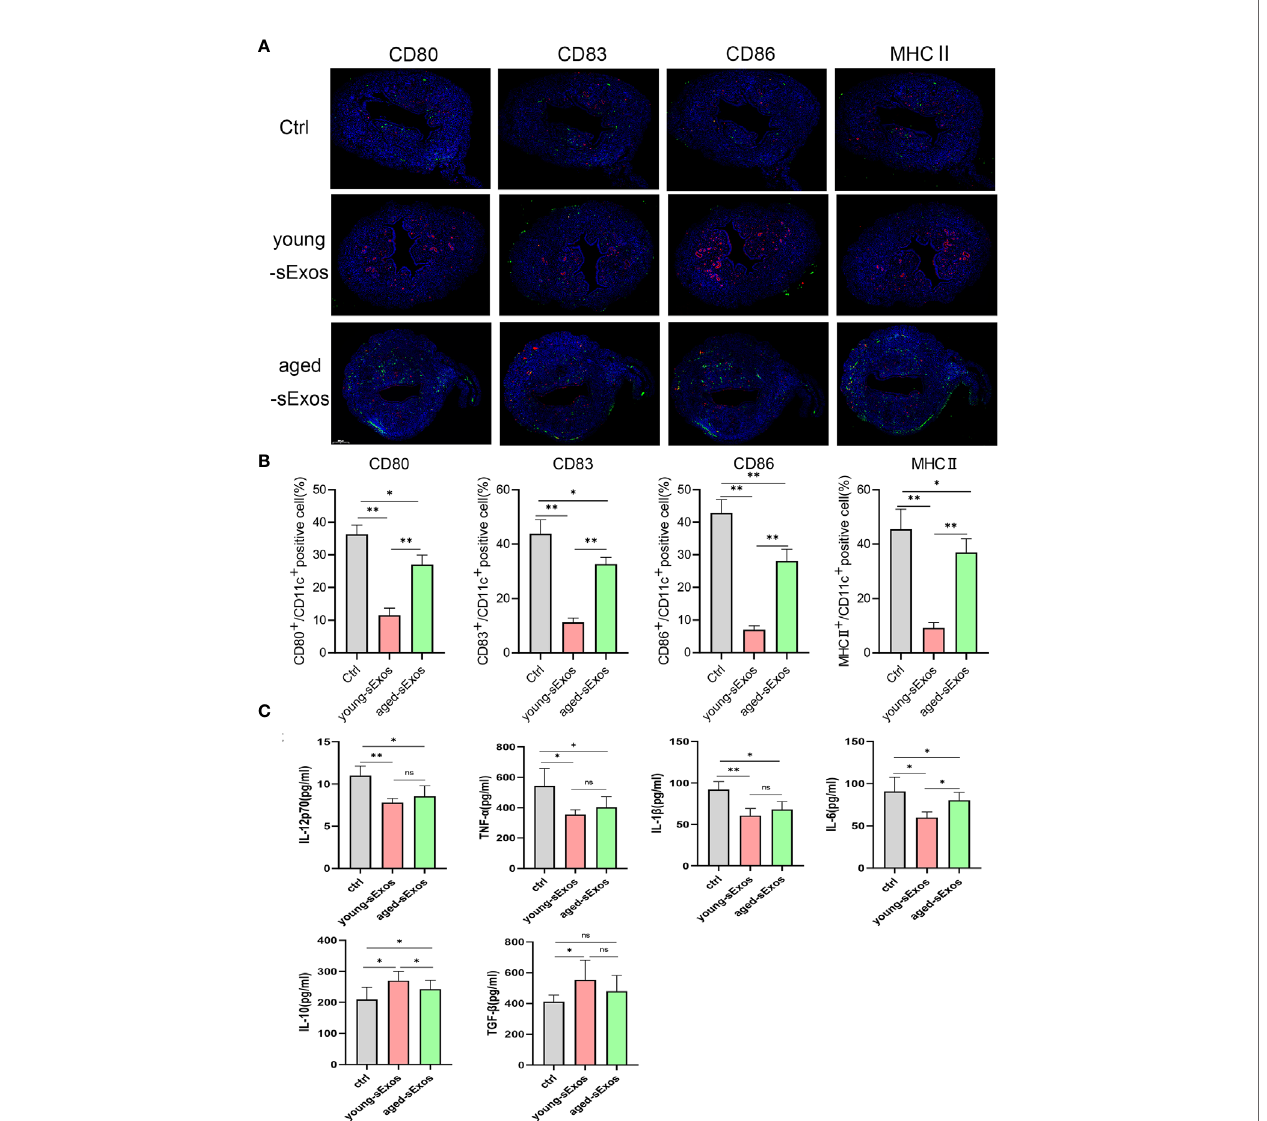
FIGURE 7 | Alterations of uterine DC maturation status between young-sExos group and aged-sExos group in vivo . (A) Representative sections of the uteri from control group, young-sExos group, and aged-sExos group mice, immunostained with anti-CD11c (red) and anti-CD80/CD83/CD86/MHCII (green) antibodies. (B) Histomorphometric quanti fi cation of DC densities in the myometrium and endometrium of control group, young-sExos group, and aged-sExos group mice. (C) ELISA analysis demonstrating the concentration of IL-12p70, TNF- a , IL-1 b , IL-10, TGF- b , and IL-6 in uterine luminal fl uid (mean ± SD, n = 6). The differences among different groups were assessed by one-way ANOVA with Holm – Sidak post-hoc test. *p < 0.05 and **p < 0.01. DC, dendritic cell; sExos, seminal plasma exosomes; ns, not signi fi